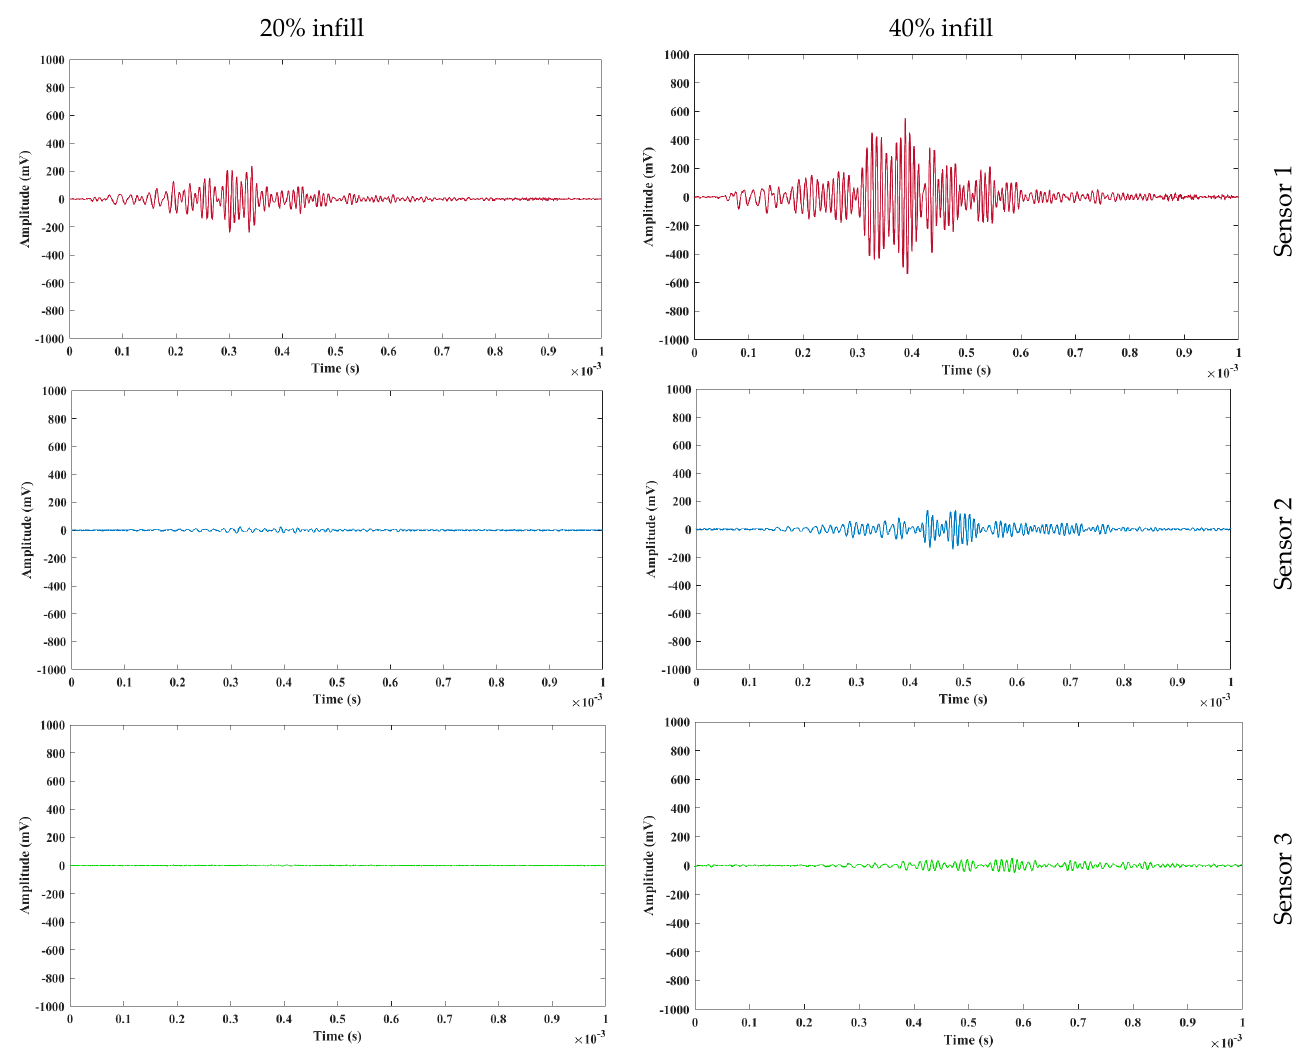
Figure 3. Time domain response graphs for parts with 20% and 40% infill.